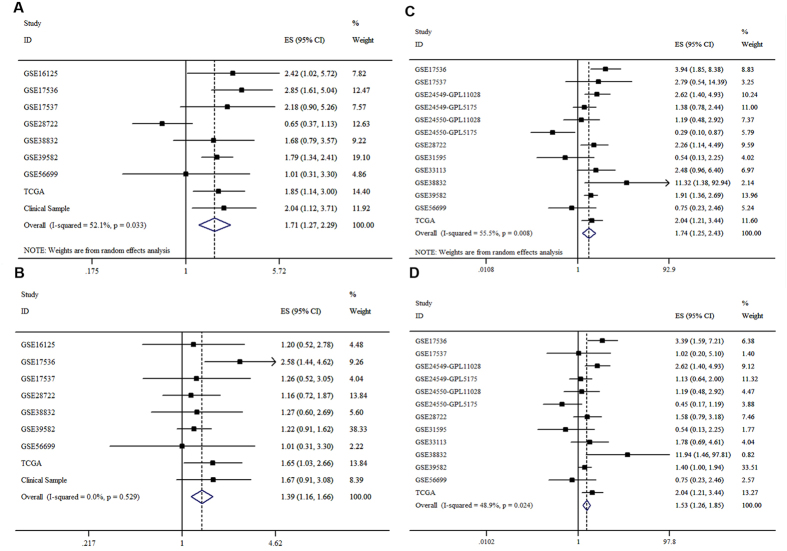
Forest plot of the association between THBS2 and CRC survival.Meta-analysis of THBS2 in seven independent datasets was conducted, and HR, 95% CI of each gene and corresponding p value were calculated and plotted in the forest plot. (A) Forest plot of the association between THBS2 filtered by ROC with a random-effect model in datasets containing OS information. (B) Forest plot of the association between THBS2 filtered by p50 with a fixed-effect model in datasets containing OS information. (C) Forest plot of the association between THBS2 filtered by ROC with a random-effect model in datasets containing DFS information. (D) Forest plot of the association between THBS2 filtered by p50 with a random-effect model in datasets containing DFS information.